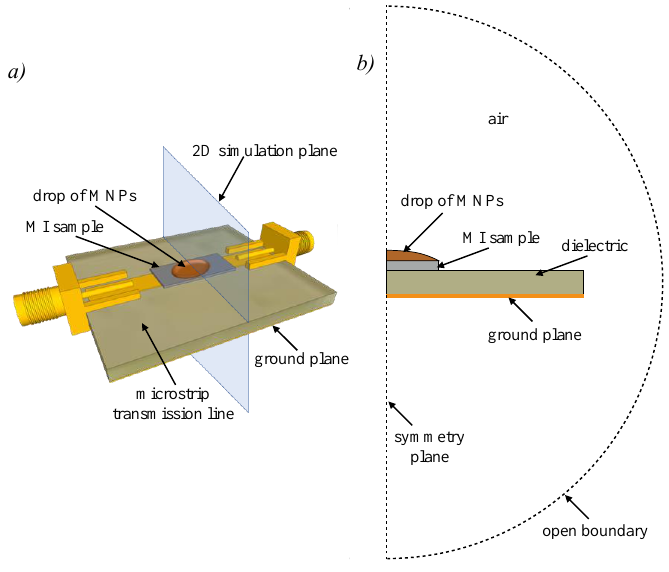
Figure 2. ( a ) Illustration of the experiment simulated by FEM: a drop containing a certain concentration of magnetic nanoparticles (MNPs) is placed on the MI material, which is inserted in a microstrip line to determine its impedance. ( b ) Layout (not at real-scale) of the two-dimensional problem solved by FEM, which corresponds to the middle plane of the setup as indicated in ( a ). Only half of the plane needs to be simulated due to